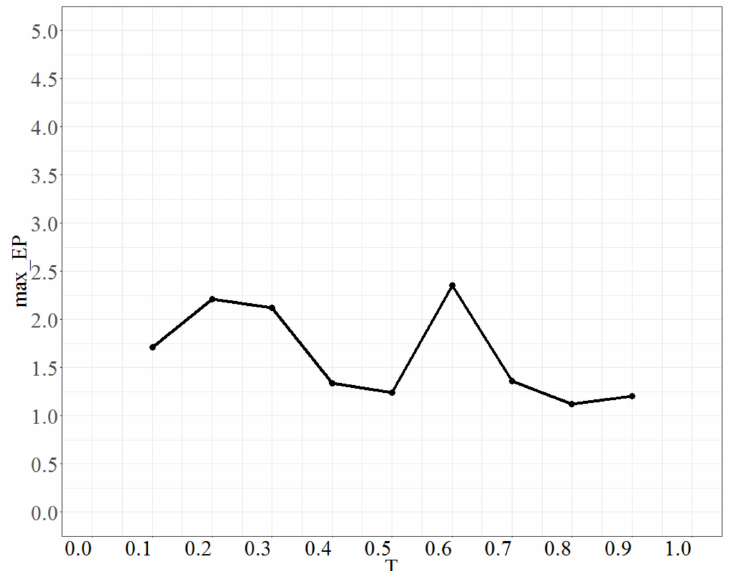
Figure 2. The behavior of max_EP as T changes.